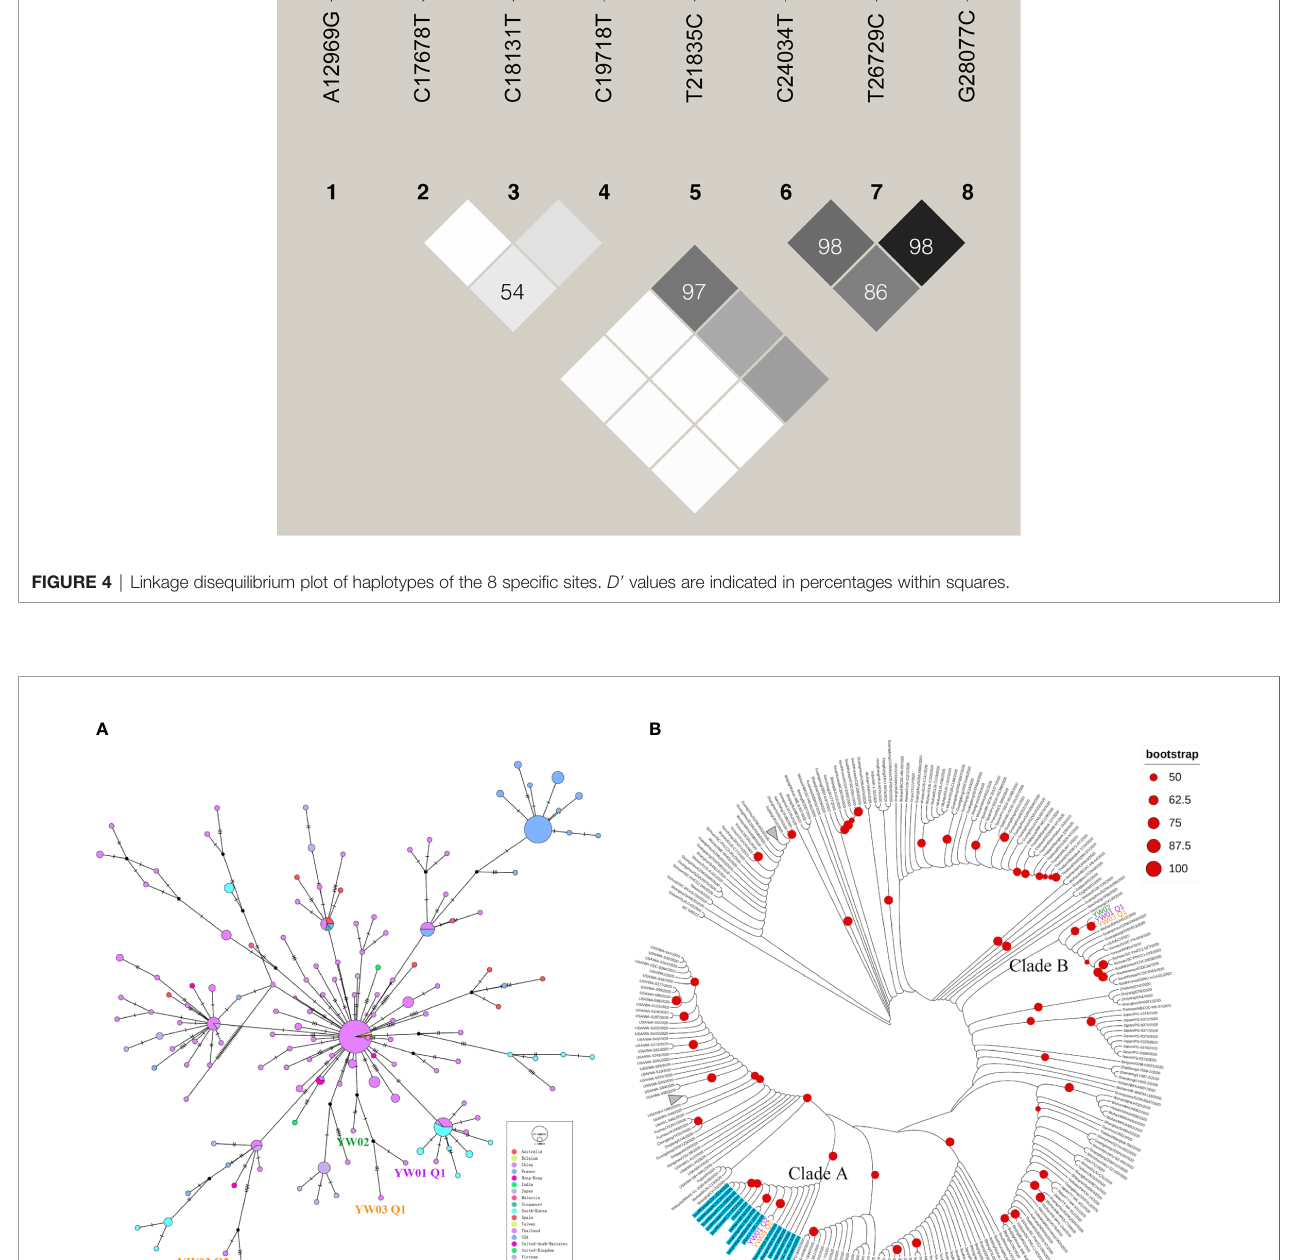
FIGURE 5 | Evolutionary relationship of YW haplotypes and GISAID S strains. (A) Median-joining haplotype network of 302 SARS-CoV-2 haplotypes, including 5 YW haplotypes, GISAID S strains from Jan. to Feb. 2020 and NC_045512.2; (B) Maximal likelihood phylogenetic tree based on all coding regions of the 302 SARS- CoV-2 showed 5 YW haplotypes were separated into different clades (Clade A and Clade B). Strains harbored variants C24034T, T26729C, and G28077C are highlighted in blue (including YW01 Q2 and YW03